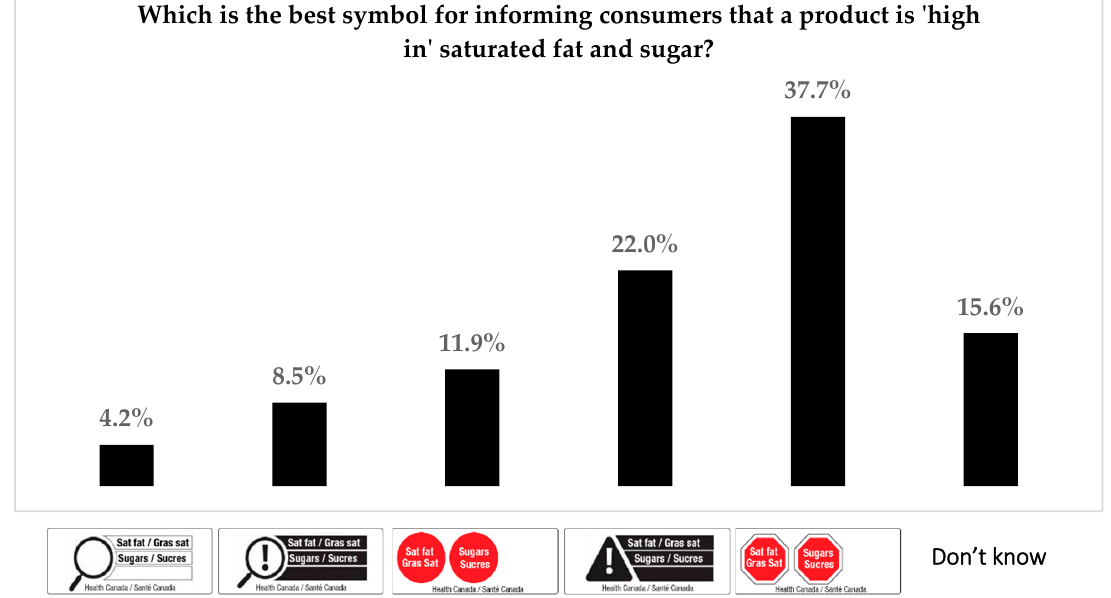
Figure 3. Responses to perceptions task: most informative front-of-package symbol ( n = 11,617).